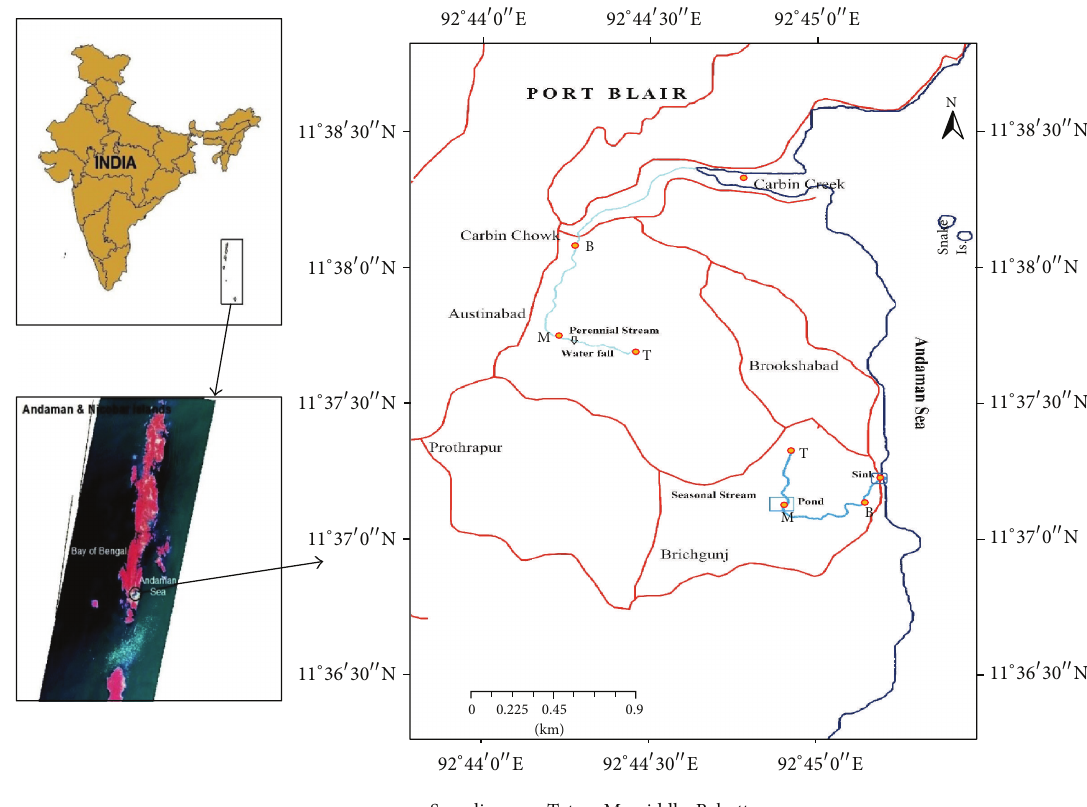
Figure 1: Map showing the study area.